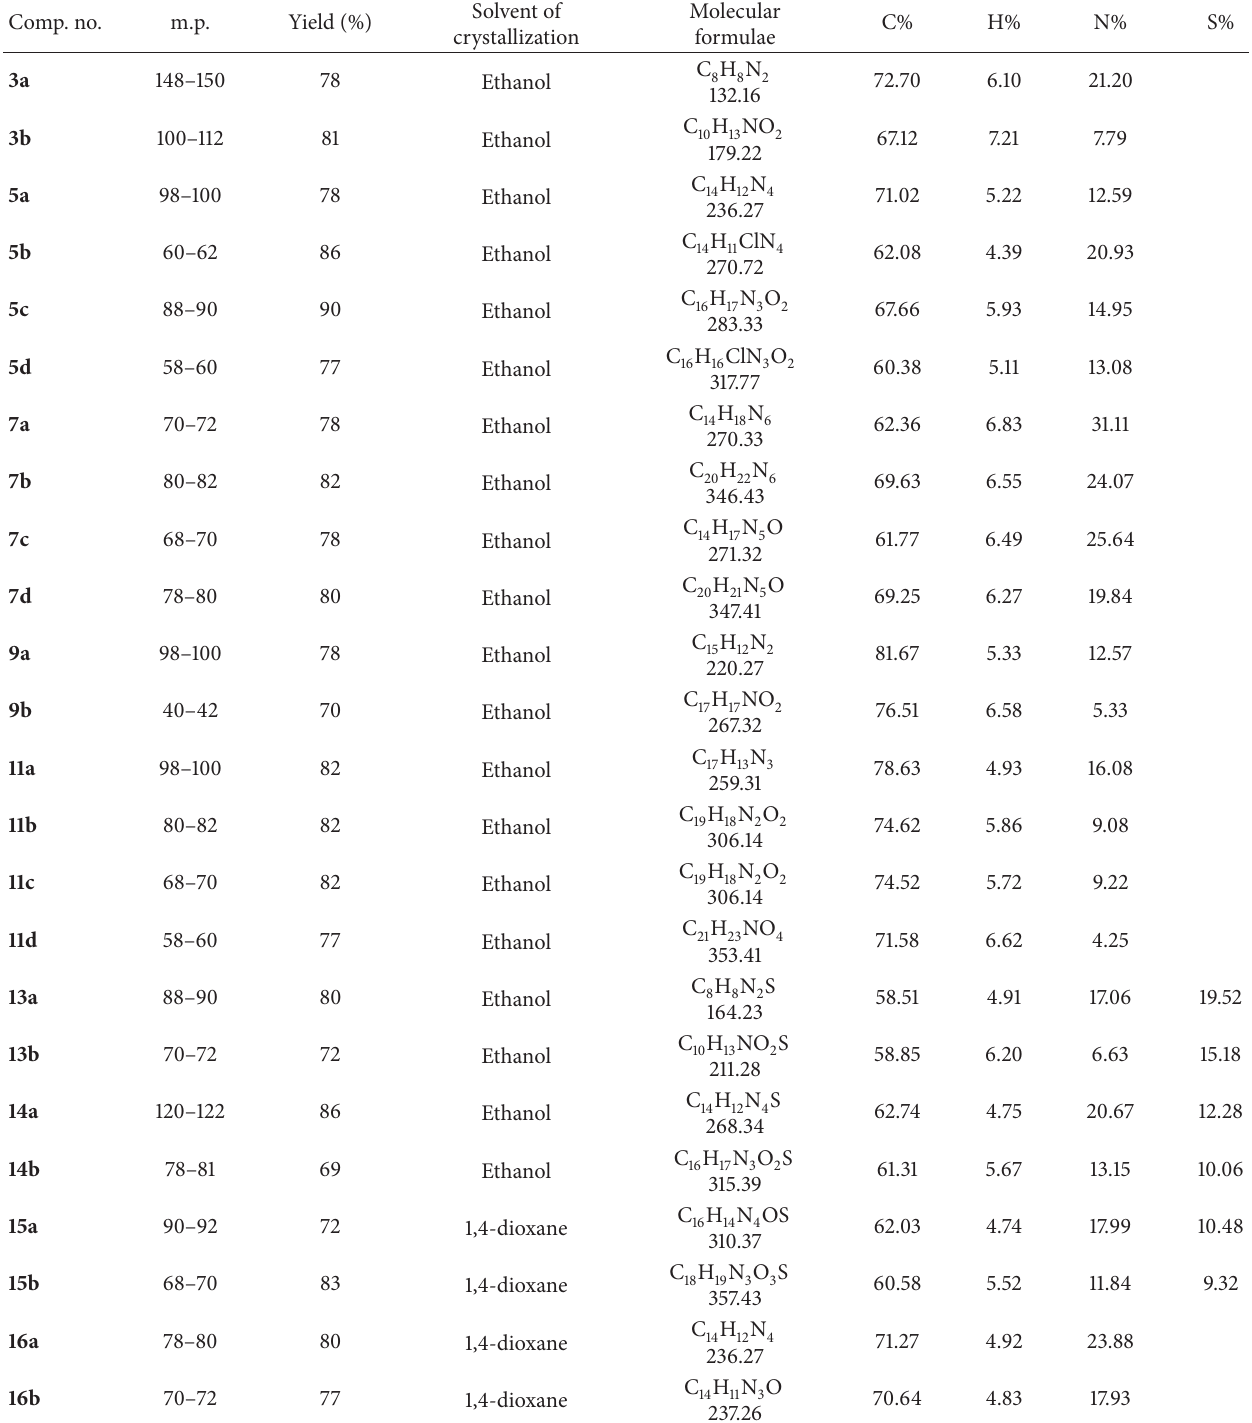
Table 1: Physical and microanalysis of the newly synthesized compounds 3a – 16b . Comp.